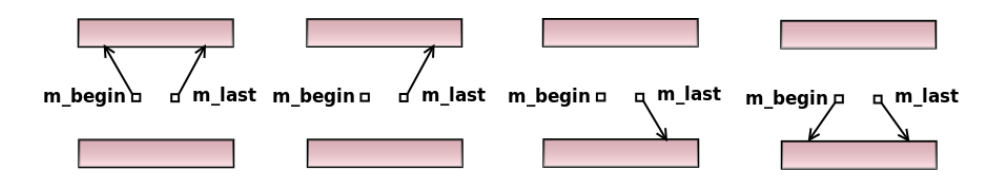
Figure 4. Procedure for updating the two pointers that delimit the valid entries (see